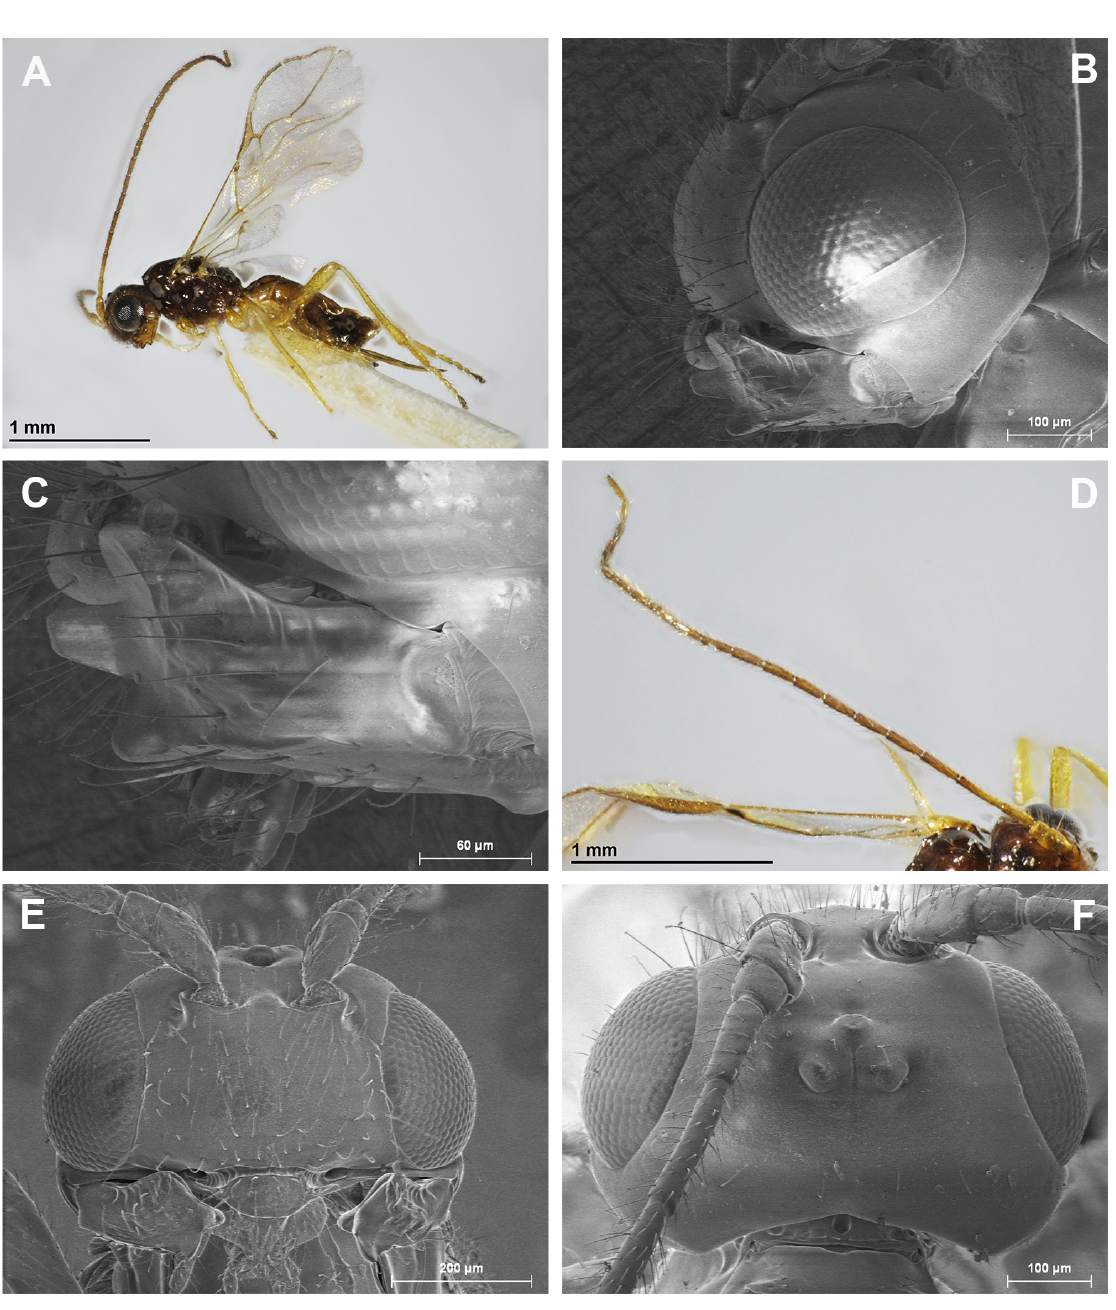
Fig. 19. Asobara ghesquierei (Fischer, 1963), ♀, holotype (MRAC). A . Habitus, lateral view. B . Head, lateral view. C . Mandible. D . Antenna. E. Head, front view. F . Head, dorsal